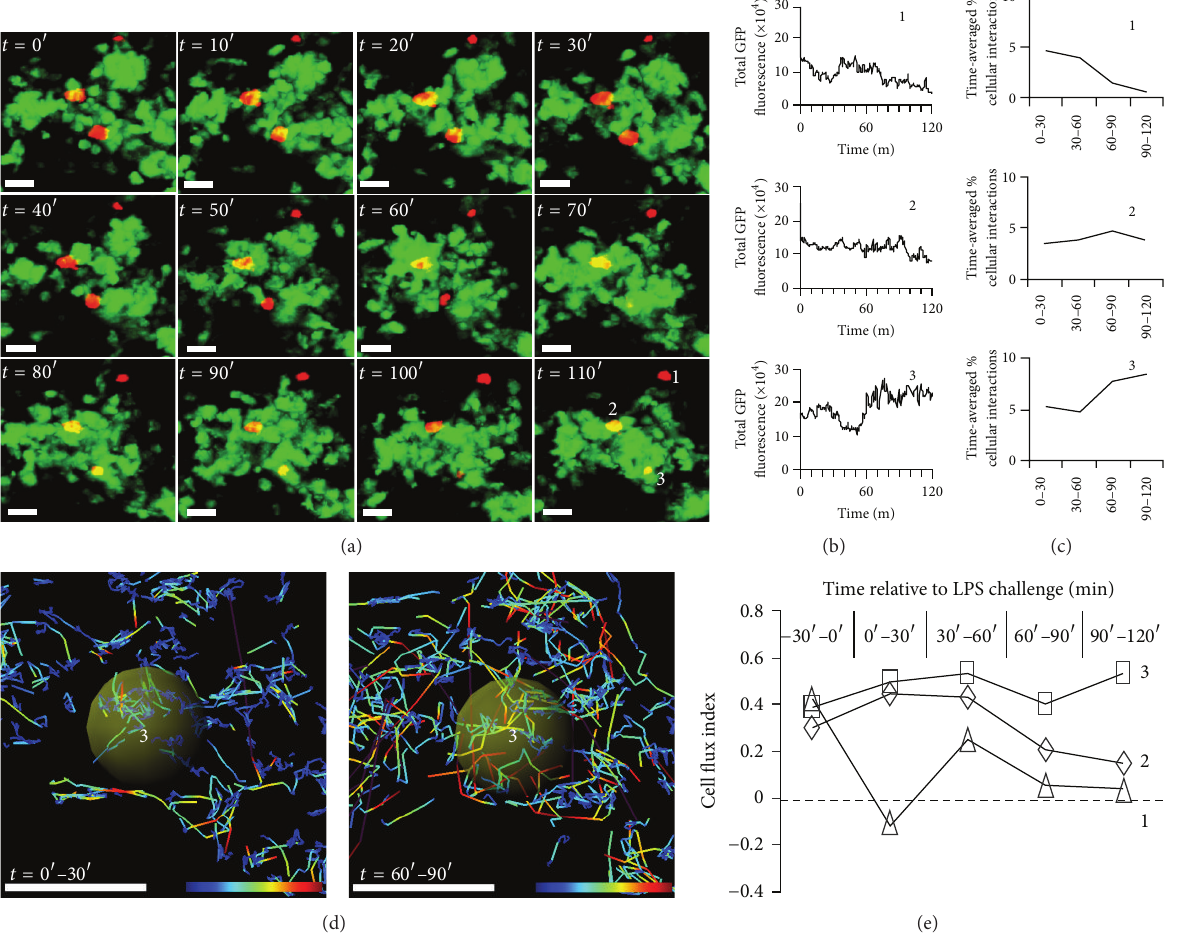
Figure 3: Time-lapse TPM images of LysM + granulocytes interacting with hMSC after systemic LPS administration. CTO-labeled hMSCs (red) were injected i.v. into a 𝐿𝑦𝑠𝑀 +/𝐺𝐹𝑃 recipient mouse containing LysM + (green) granulocytes 20 hours prior to performing intravital TPM of the bone marrow through intact calvarium of the live recipient mouse. The recipient mouse received a 100ng of LPS injection i.v. at relative time = 0min ( 𝑡 = 0 󸀠 ). (a) Sequential TPM images from Supplemental Movie 1 (See Supplementary Materials available online at http://dx.doi.org/10.1155/2013/656839) displayed at 10-minute intervals for a total of 110 minutes ( 𝑡 = 110 󸀠 ) starting from the time of LPS injection ( 𝑡 = 0 󸀠 ), showing the accumulation of LysM + GFP + granulocytes surrounding 2 out of 3 hMSCs (red) that are clearly visible within the imaging field. Scale bar = 20 𝜇 m. (b) Total fluorescence of GFP signal within a 20 𝜇 m radius of each of the three hMSCs identified in (a) at 𝑡 = 110 󸀠 over time. (c) Time-averaged percent of LysM + GFP + neutrophils within 20 𝜇 m radius of the hMSC that formed a cell-cell contact with the said hMSCs after LPS challenge. The percent was normalized to the contact frequency at 𝑡 = 0 󸀠 . (d) Track analysis of cell number 3 in (a) 𝑡 = 110 󸀠 . Shown are migration tracks of surrounding LysM + GFP + granulocytes during 0 to 30 minutes (left panel) and 60 to 90 minutes (right panel) after LPS administration. Individual migration heat map tracks are color-coded based on the calculated instantaneous speed. Yellow sphere = 20 𝜇 m radius around the center of hMSC number 3. Scale bar = 50 𝜇 m. (e) Cell flux indices for 3 different hMSCs identified in (a) are shown, where all three hMSCs showed net increased neutrophil flux towards them after LPS administration, although hMSC number 3 exhibited heightened and sustained positive cellular flux. hMSC number 2 had an initial increase in positive flux, which reached homeostasis two hours after LPS injection. hMSC number 1 initially had a negative cellular flux due to local neutrophils being attracted to hMSCs number 2 and number 3. However, neutrophils from regions beyond the imaging field began to migrate towards the hMSC 30 to 60 minutes following LPS injection before the cellular traffic reached a steady-state level (cell flux index of ∼